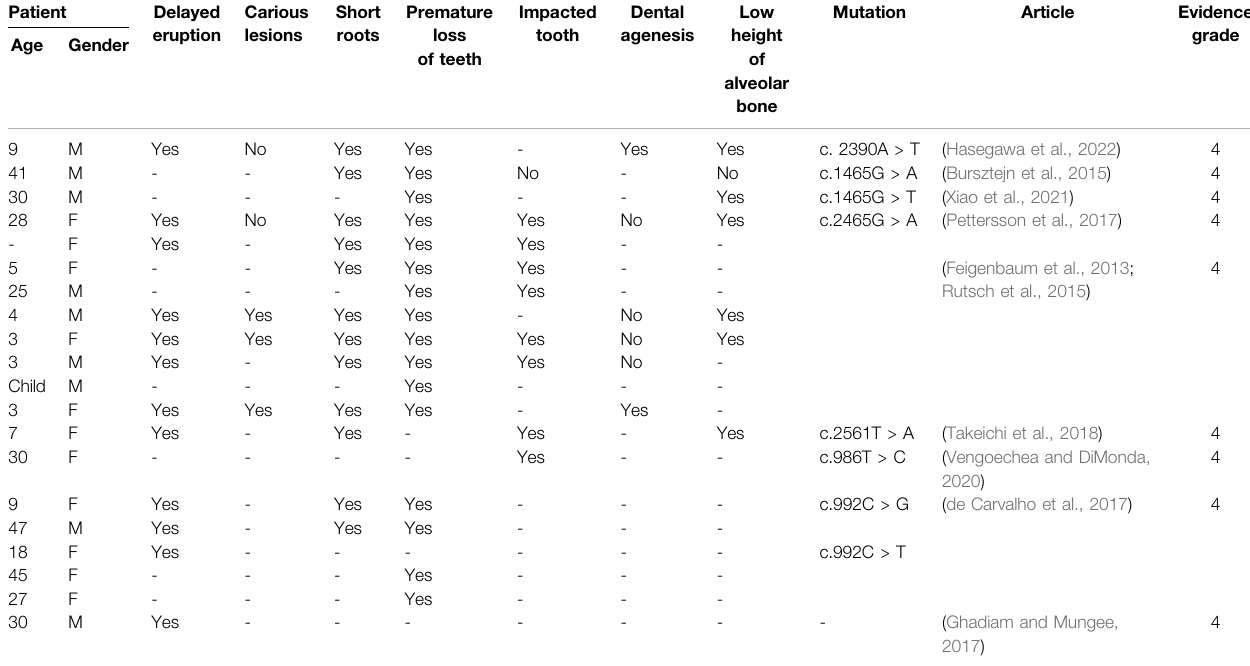
TABLE 2 | Patients ’ dental